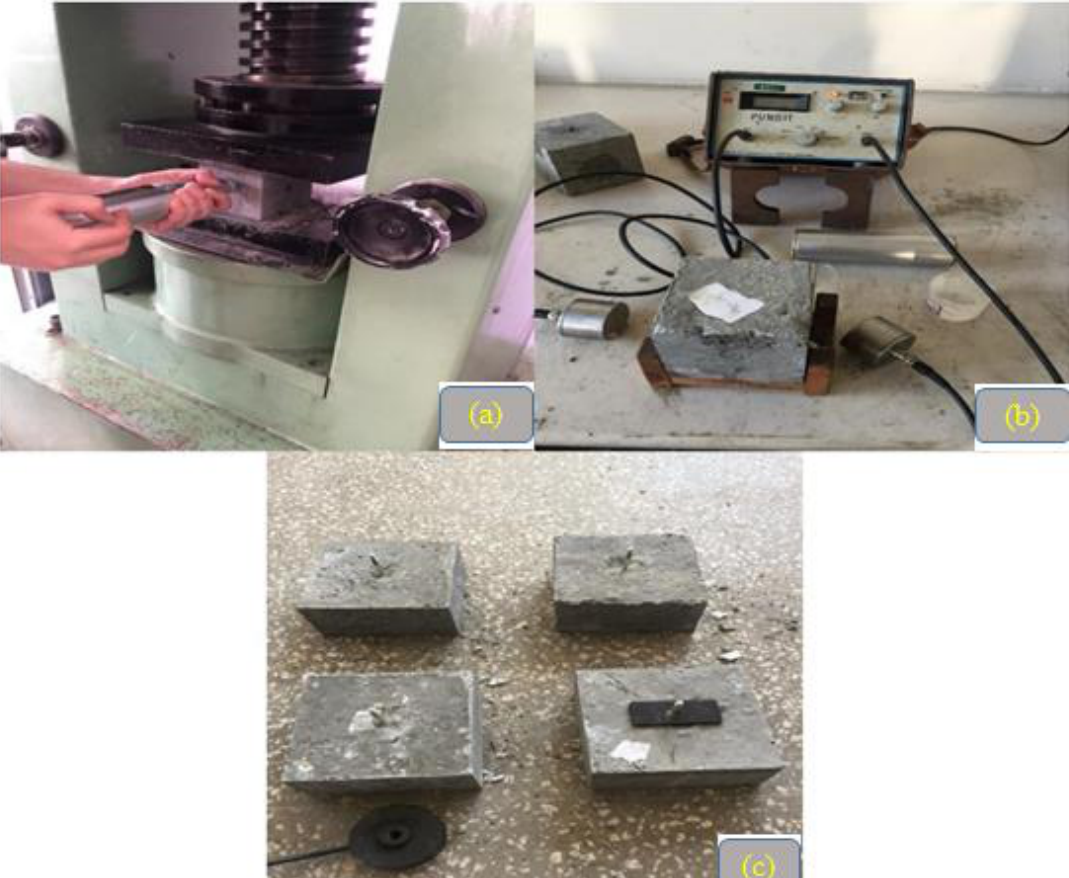
Figure 3. Applied non-destructive tests on concrete samples: ( a ) Surface hardness ( b ) Ultrasonic pulse velocity. ( c ) Penetration resistance .